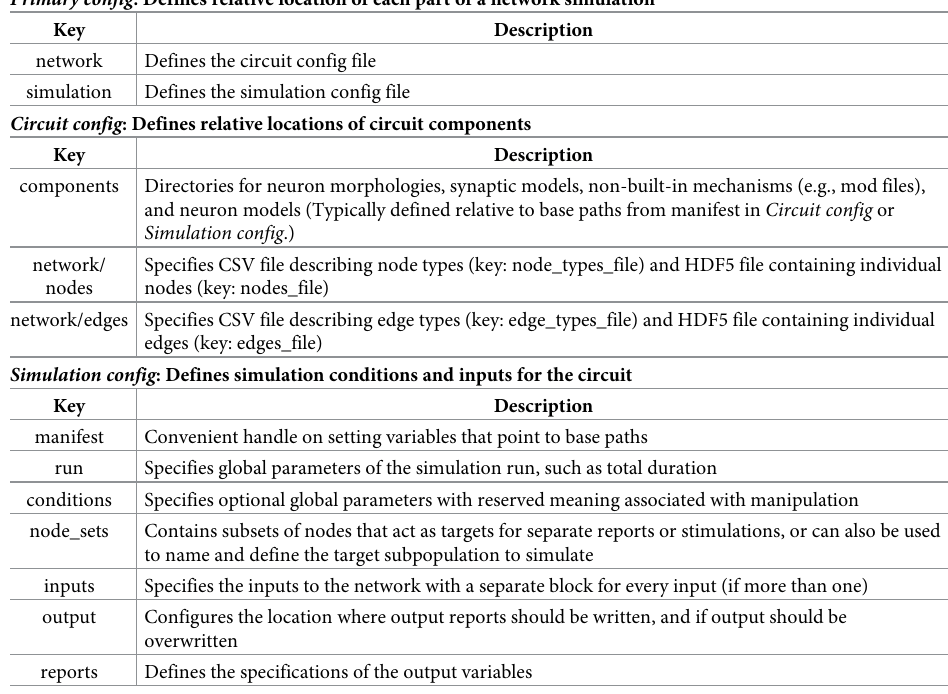
Table 2. Summary of the config files. Representative components are listed; additional entries can be used as described in the Online Documentation . Primary config : Defines relative location of each part of a network